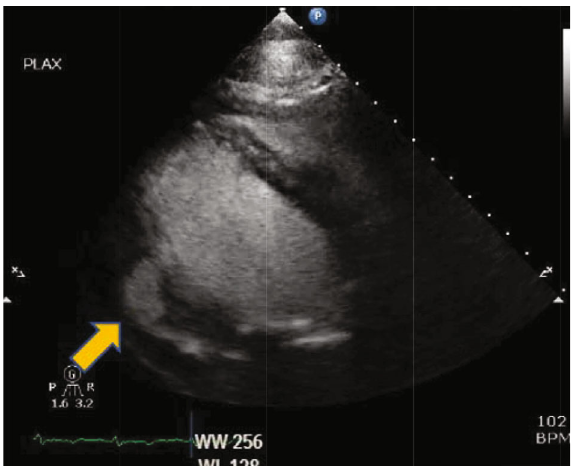
Figure 1: Parasternal long axis view of contrast leaking into the pericardial space on echocardiogram.